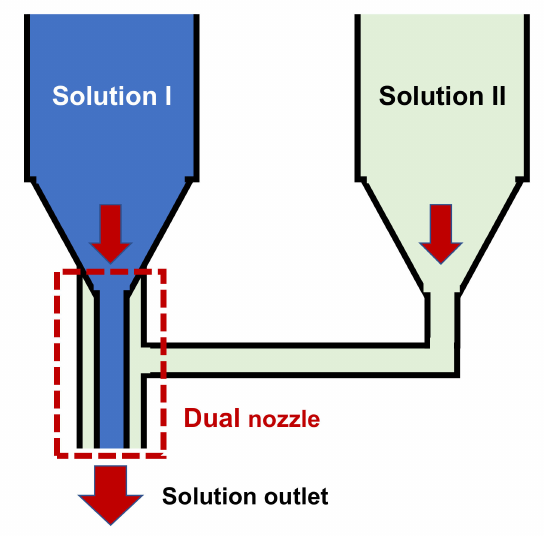
Figure 10. Structure of dual nozzle for electrospinning. Lee et al. used the dual nozzle to fabricate porous, hollow CNFs with gold nanoparti- cles decorated on the inside (Figure 11a) [81]. Although the inner nozzle was fed with a poly(styrene-co-acrylonitrile) solution containing gold chloride (AgCl 3 ), the outer nozzle was fed with a PAN solution mixed with poly(styrene-co-acrylonitrile). The dual noz- zle allows the copolymer to stay inside and create a copolymer core for the electrospun nanofibers. After carbonization, the copolymer is decomposed and the gold nanoparticles remain attached to the carbon shell. The hollow fibers combined with catalytic magne- siophilic provided excellent magnesium (Mg) plating/stripping in metallic Mg battery applications.